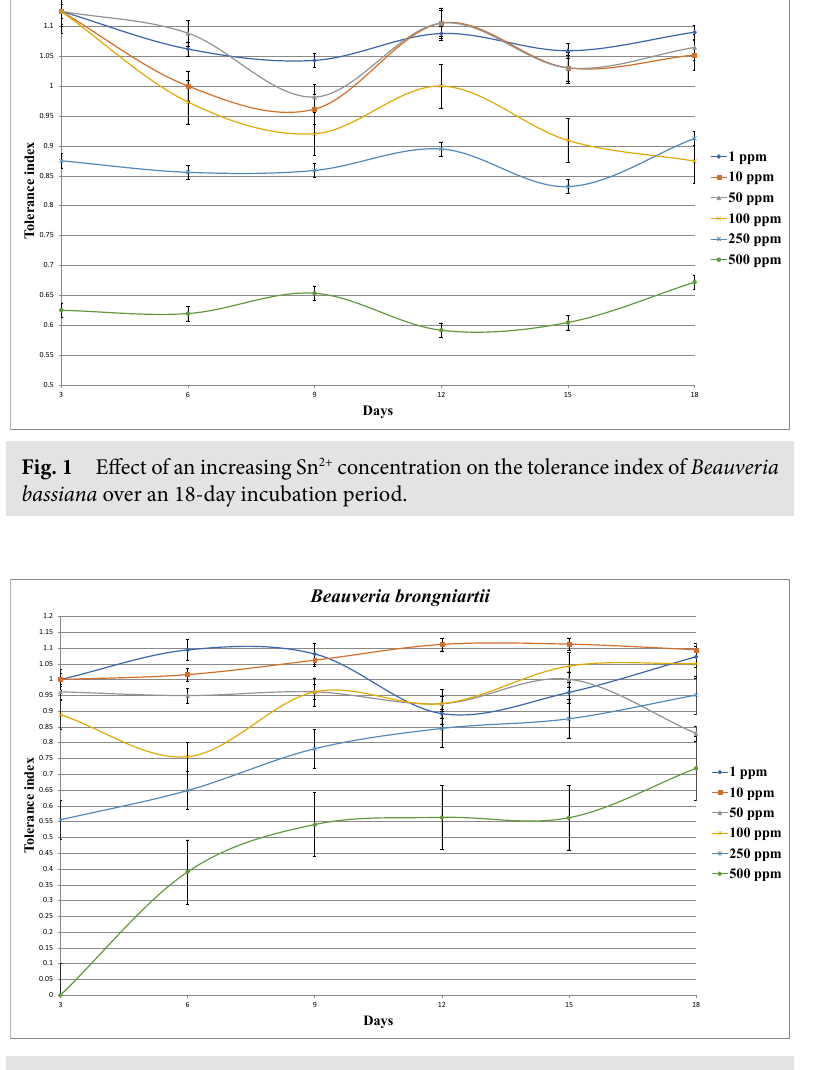
Fig. 2 Effect of an increasing Sn 2+ concentration on the tolerance index of Beauveria brongniartii over an 18-day incubation period.